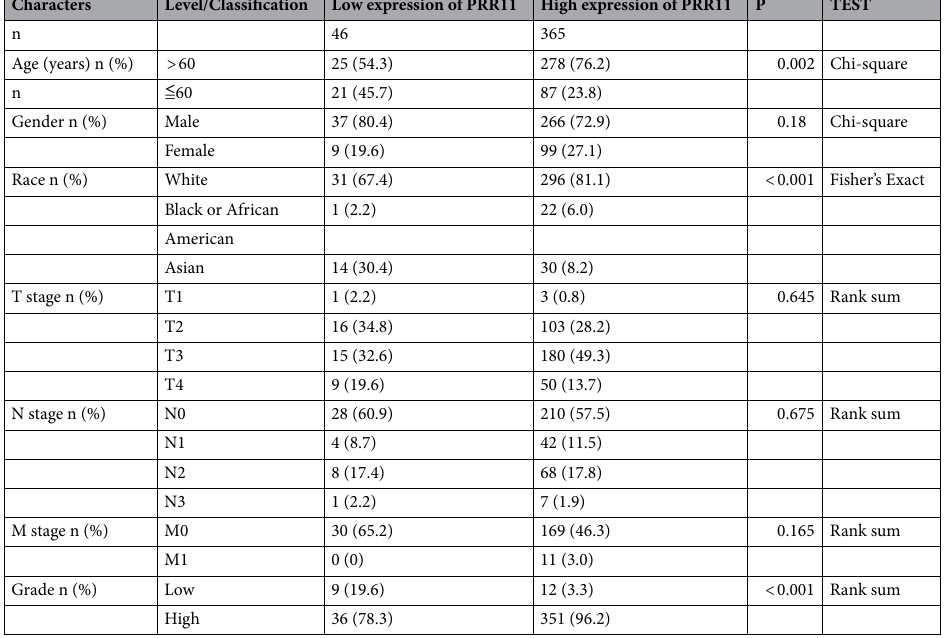
Table 1. Correlation between PRR11 expression and clinicopathological characteristics in BLCA.